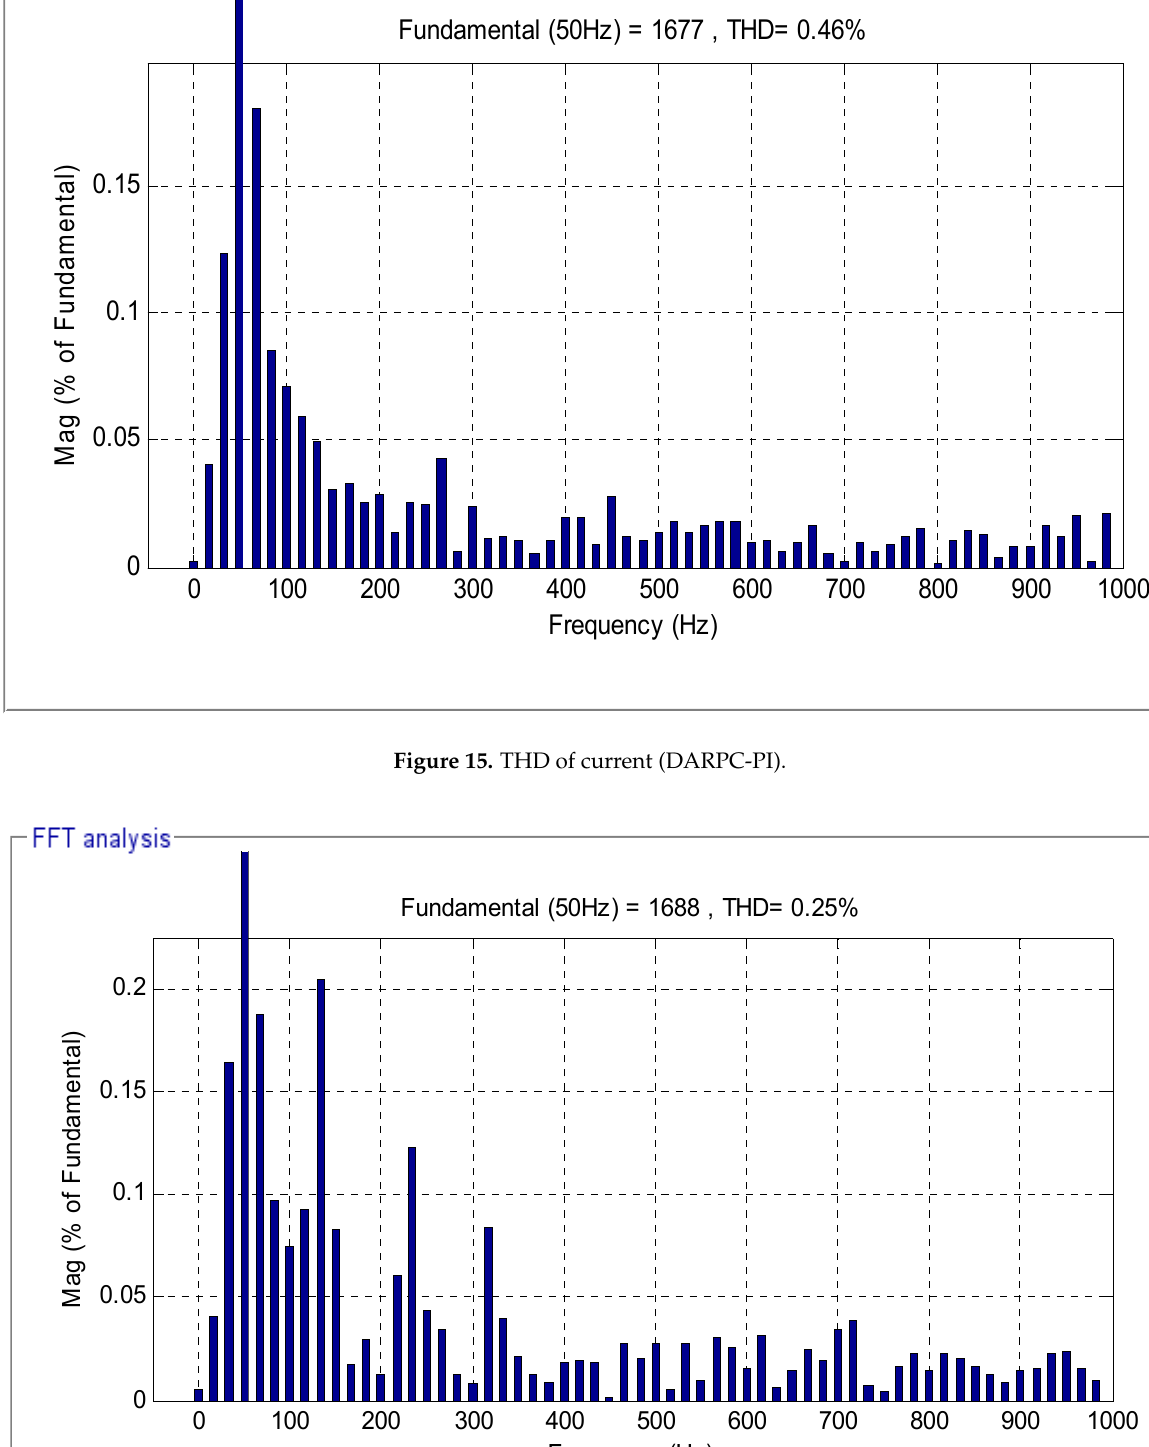
Figure 14. Zoom (Current).